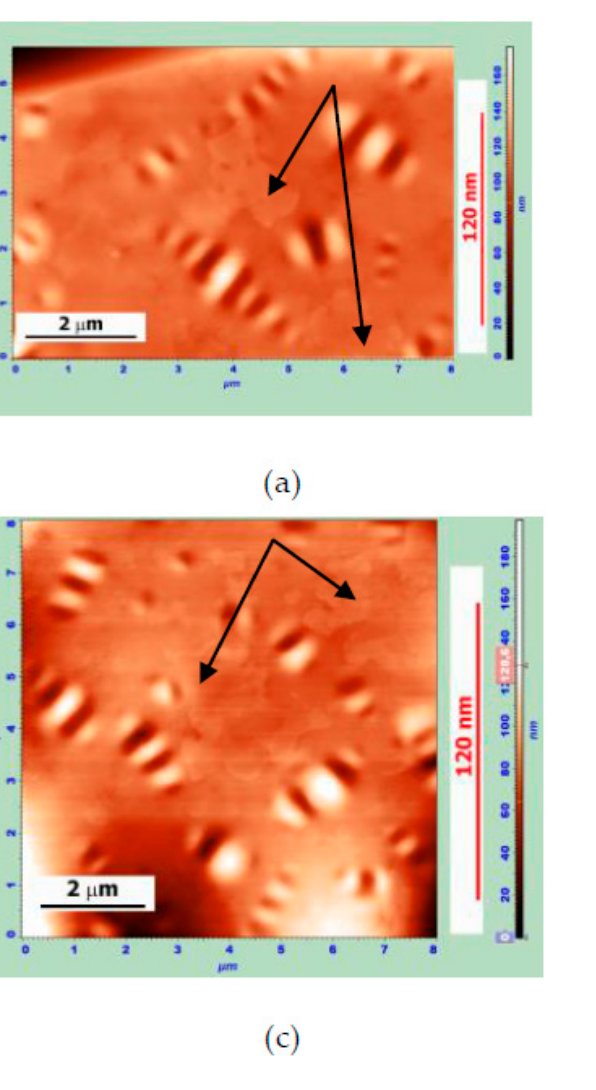
Figure 6. AFM surface images of the MB sample of composition 90 wt.% Bit-A + 10 wt.% APDDR, obtained after 2 days after sample preparation. ( a , c )—topography, ( b )—AFM-3D image; ( d )—phase image. ( a , b )—8 × 6 μ m, ( a ) Z-coordinate—175 nm; ( c , d )—8 × 8 μ m, ( c ) Z-coordinate—195 nm. Thin films are indicated by arrows.